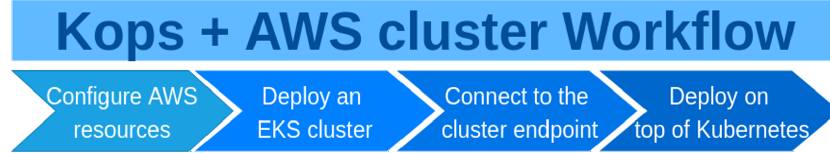
Figure 3. Stages of working with Kubernetes cluster deployed on AWS with kops.